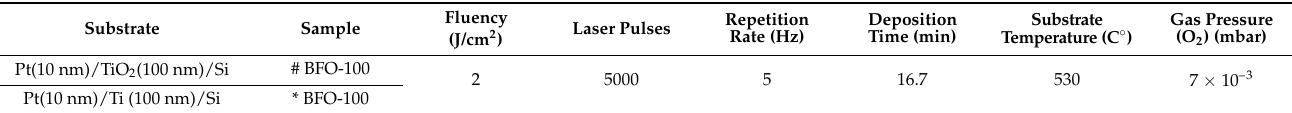
Table 1. Deposition conditions of BiFeO 3 thin films by